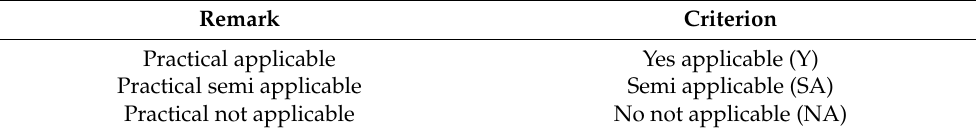
Table 2. Matching